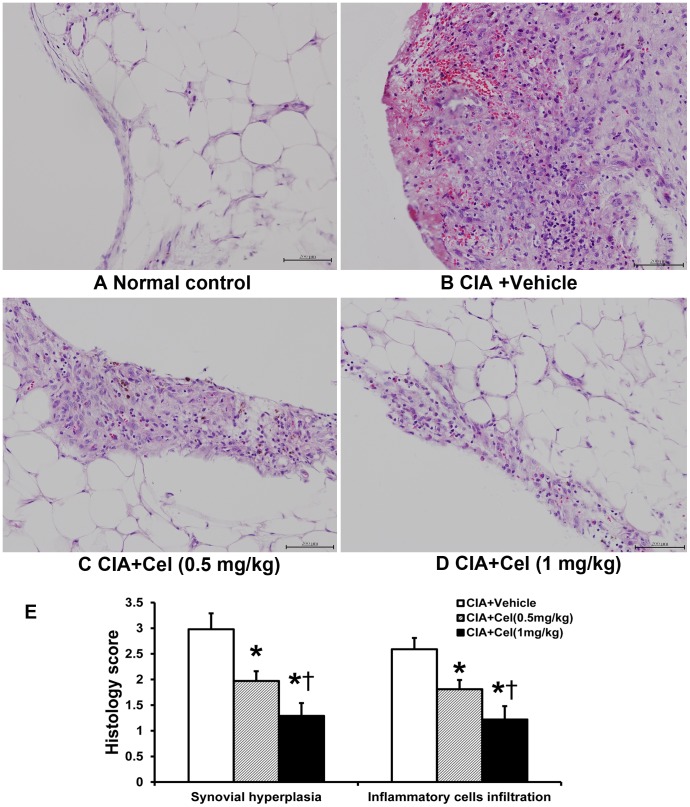
Celastrol improves histopathology of CIA rats.
A–D: On day 20 after the primary immunization, CIA rats received celastrol (0.5 and 1 mg/kg, intraperitoneally) daily for 3 weeks. The histological features of right hind knee joint synovium from Normal control, CIA+Vehicle, CIA+Cel (0.5 mg/kg), and CIA+Cel (1 mg/kg) groups were assessed by H&E staining. E: Comparisons of histological scores among groups (n = 8 observations each group). The H&E stained sections were scored for the degree of synovial hyperplasia and inflammatory cells infiltration by grading from 0 to 3 (scale bar: 200 µm). Values are shown as mean ± SD. *
P<0.05 versus CIA+Vehicle, †
P<0.05 versus CIA+Cel (0.5 mg/kg).